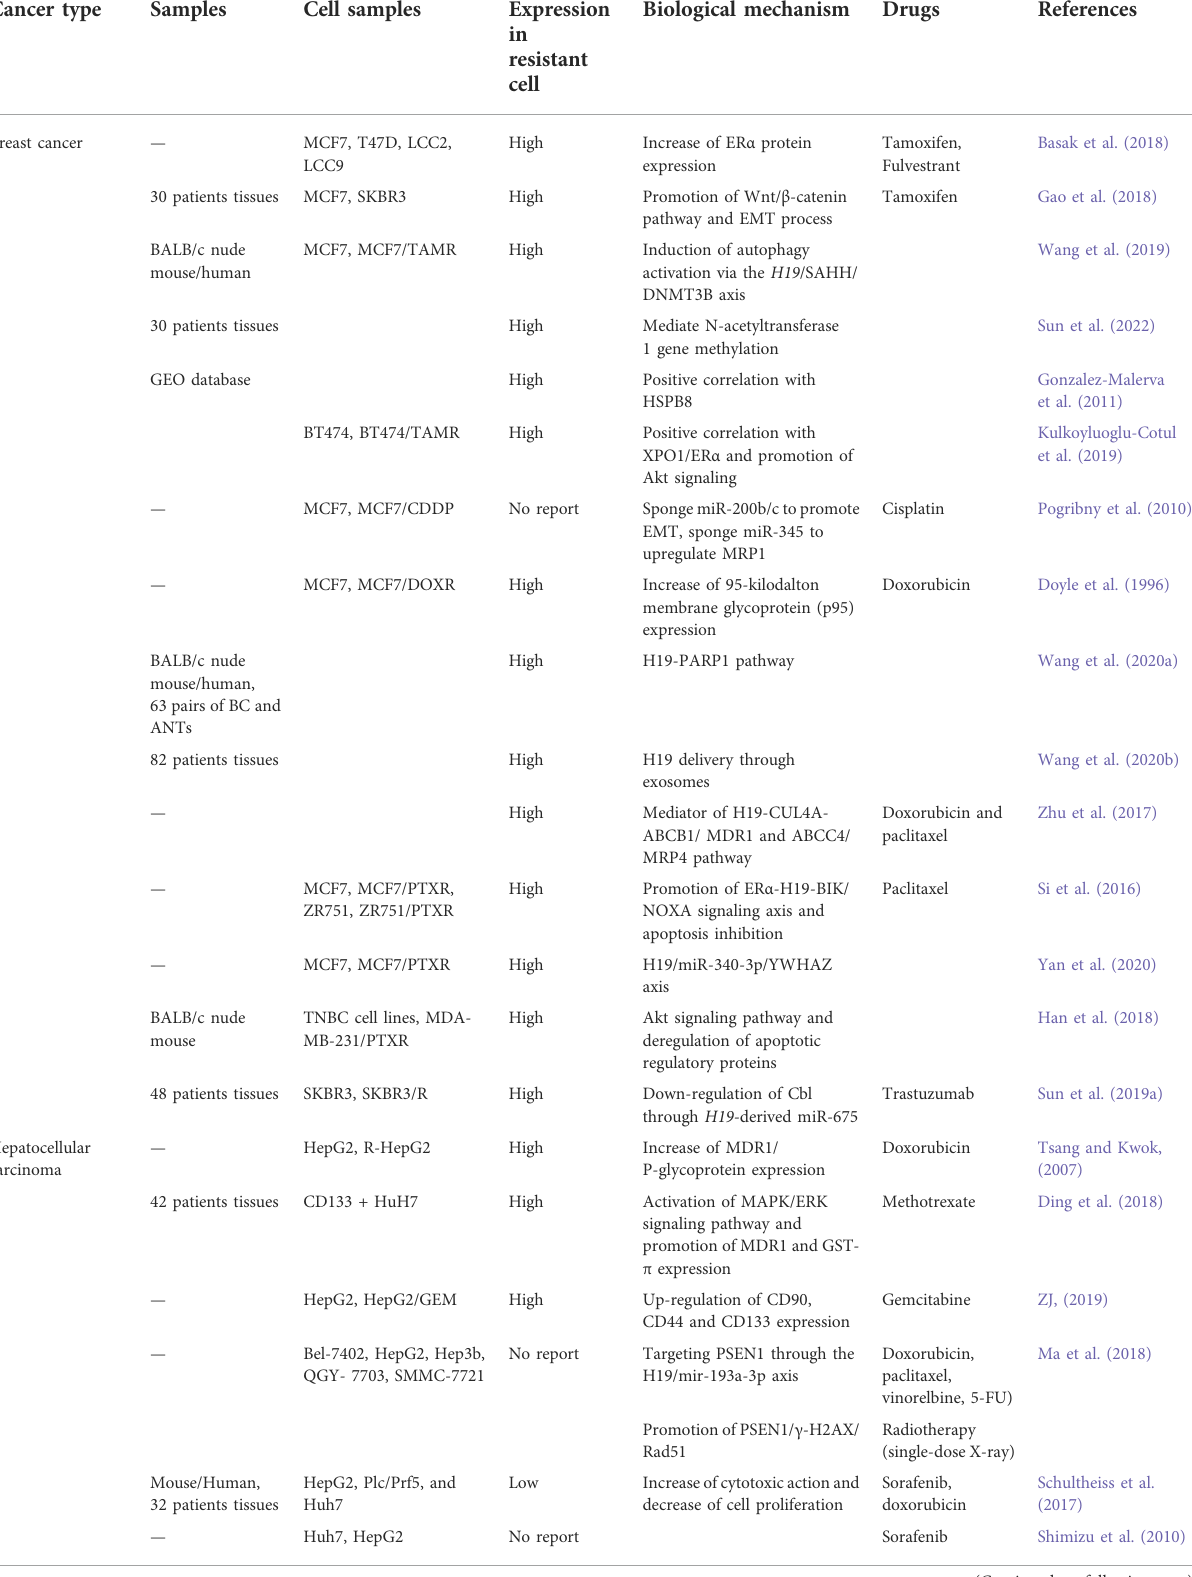
TABLE 1 Summary the drug resistance mechanisms to human cancers via